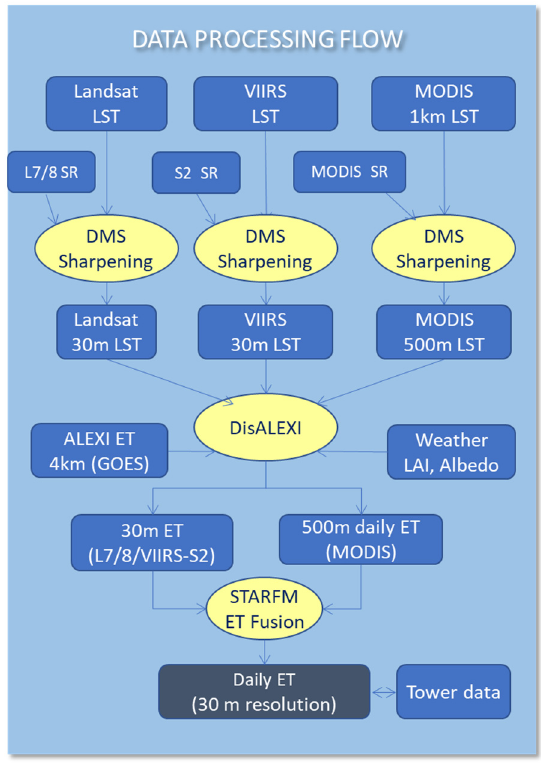
Figure 1. Schematic diagram representing the flow of multi-source ET processing and data fusion system. The schematic is adapted from Figure 2 in [29].